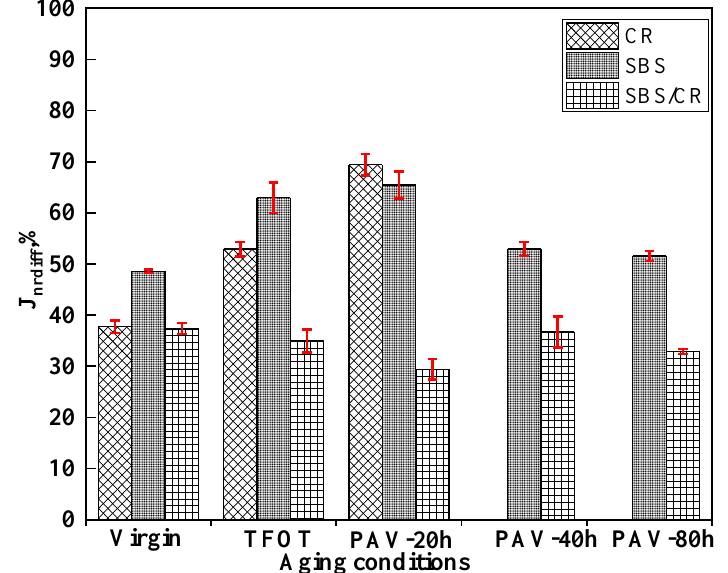
Figure 2. J nr,di ff value for three kinds of asphalt at di ff erent aging Figure 2. J nr,diff value for three kinds of asphalt at different aging conditions.